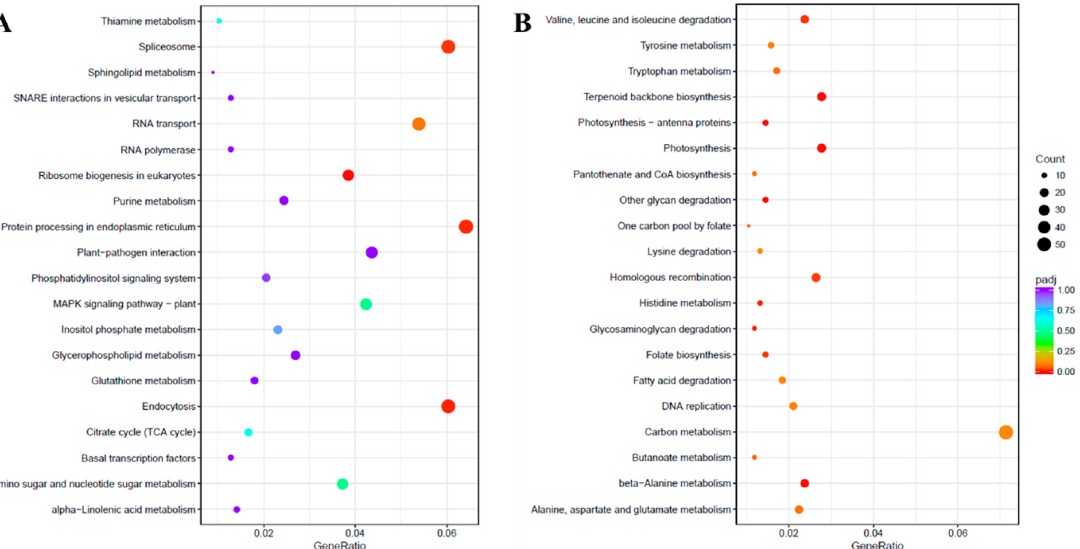
Figure 5. Kyoto Encyclopedia of Genes and Genomes (KEGG) enrichment scatter plot. The KEGG enrichment analysis showing the top 20 enriched pathways for up-regulated ( A ) and down-regulated ( B ) DEGs. The horizontal axis is GeneRatio (the ratio between the number of di ff erentially expressed genes in each pathway, and all di ff erentially expressed genes that can be found in the KEGG database). The vertical axis is the description of the KEGG term. The significance showing padj q -values are shown as a color scale, where the color and size of the dots represent the range of q -value and the number of DEGs mapped to the individual pathways, respectively.